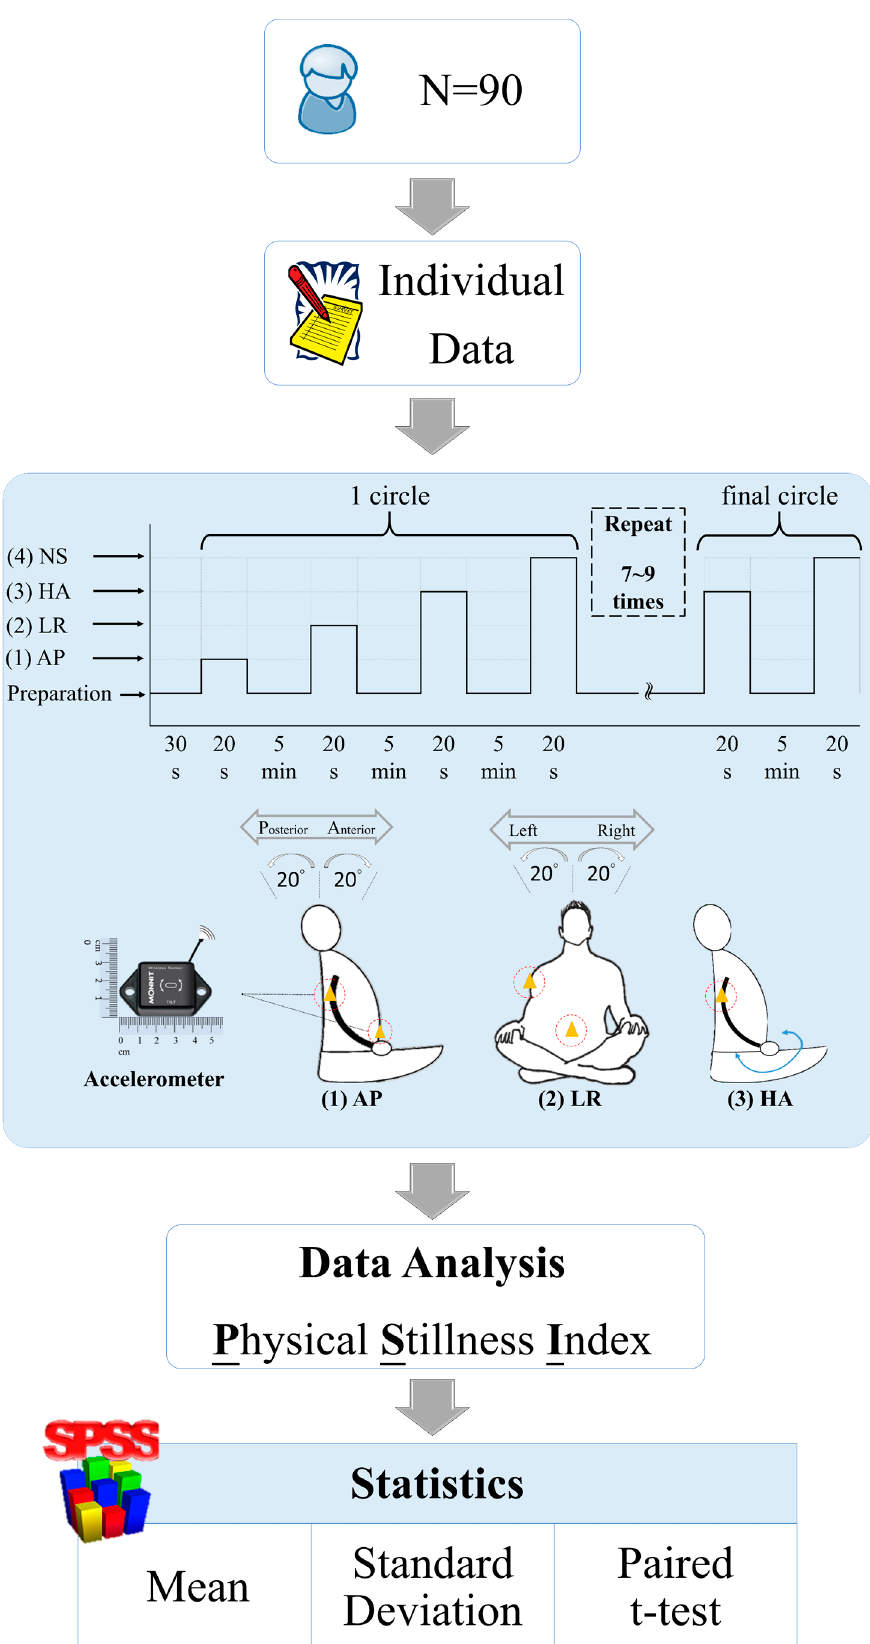
Figure 1. Flowchart of the first experiment.